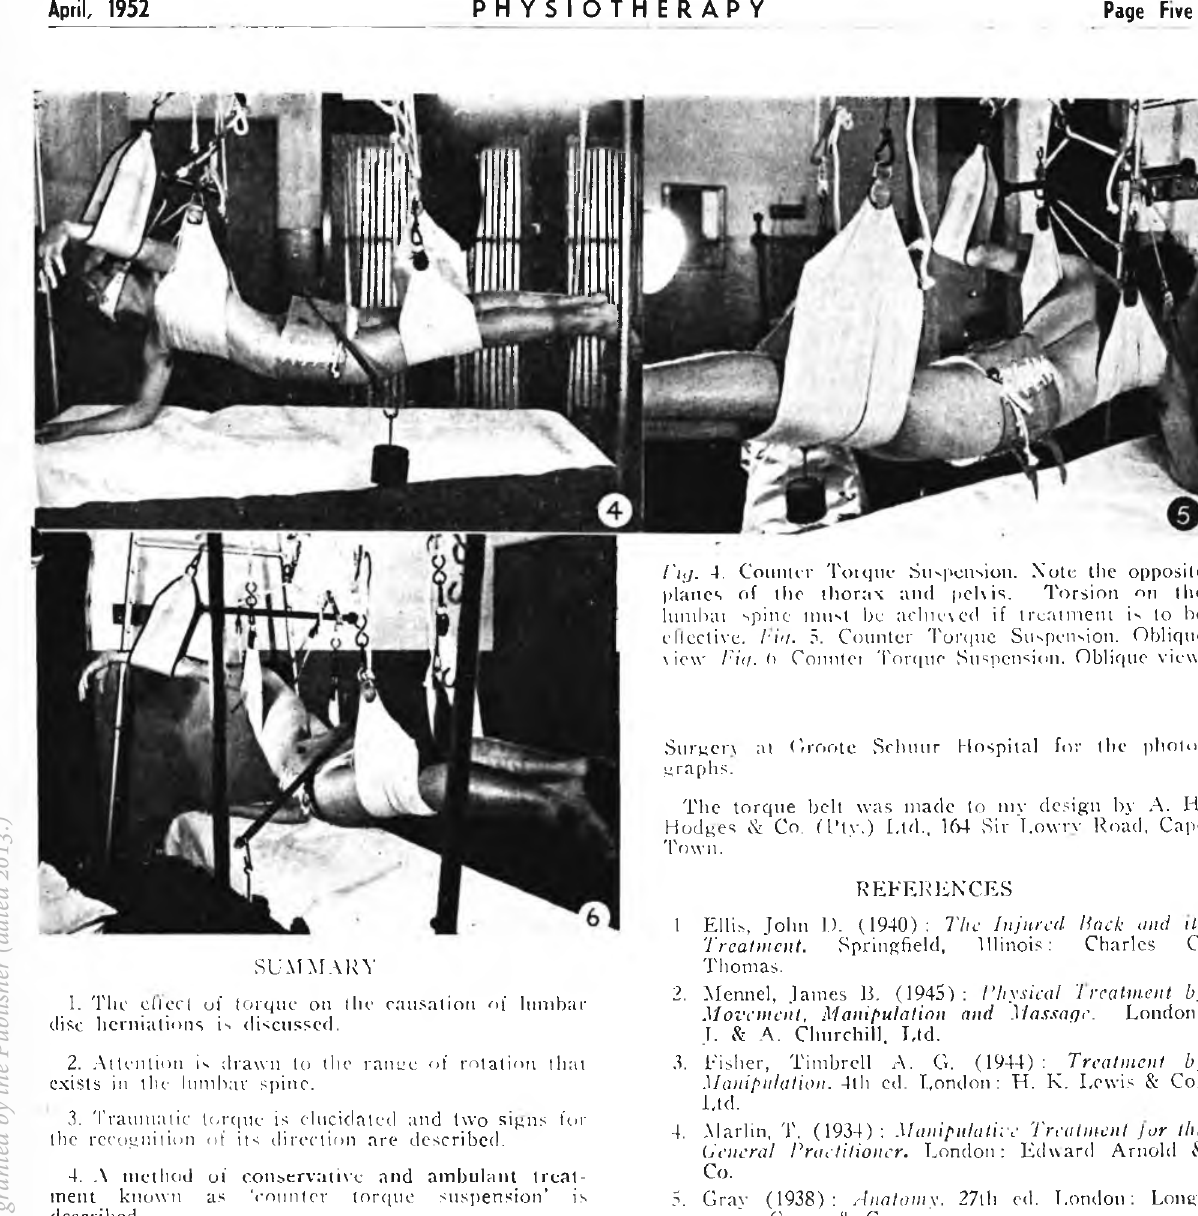
Thj. 4. Counter Toique Suspension. Xotc the opposite planes of the thorax, and pekis. Torsion on the lumbai spine must be achiexcd if treatment is to he cllective. hi'!. 5. Counter Torque Suspension. Oblique \iew Tiit. (i Conntei Torque Suspension. Oblique